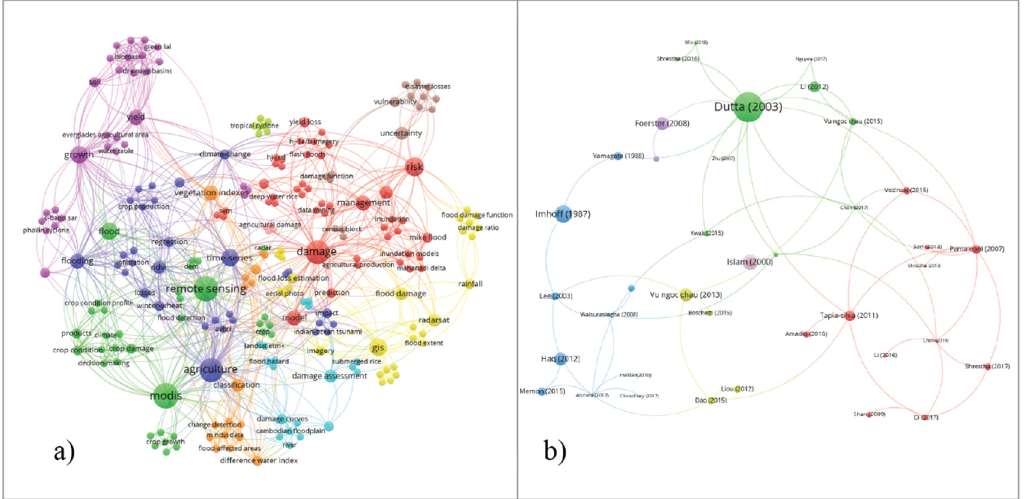
Figure 7. Co-occurrence of key words and citation network map of the selected case studies. ( a ) A cloud of keywords from the selected literature. ( b ) A Citation map of the selected literature based on the citation relationship derived from the Web of Science. The size of nodes indicates the count of citations.